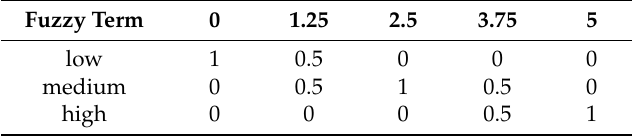
Table 1. Input membership values of cutting speed.